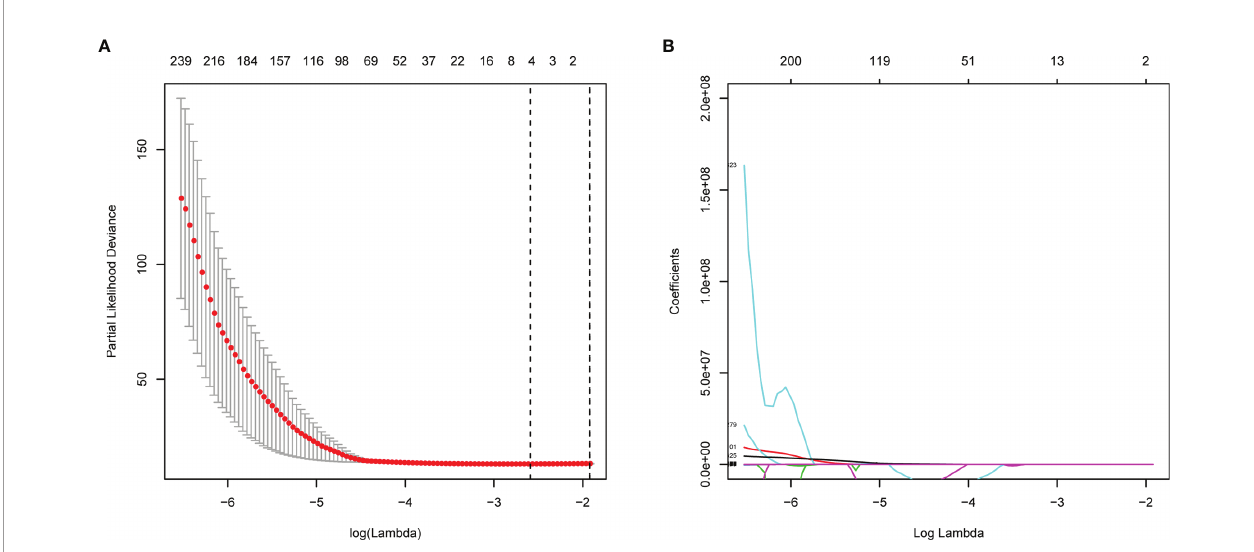
FIGURE 2 | Feature selections with LASSO Cox regression analysis. (A) l selection in the LASSO model using 10-fold cross-validation. (B) LASSO coef fi cient pro fi les of all the radiomics features. Vertical black dashed line represents the optimal resulted in nine nonzero